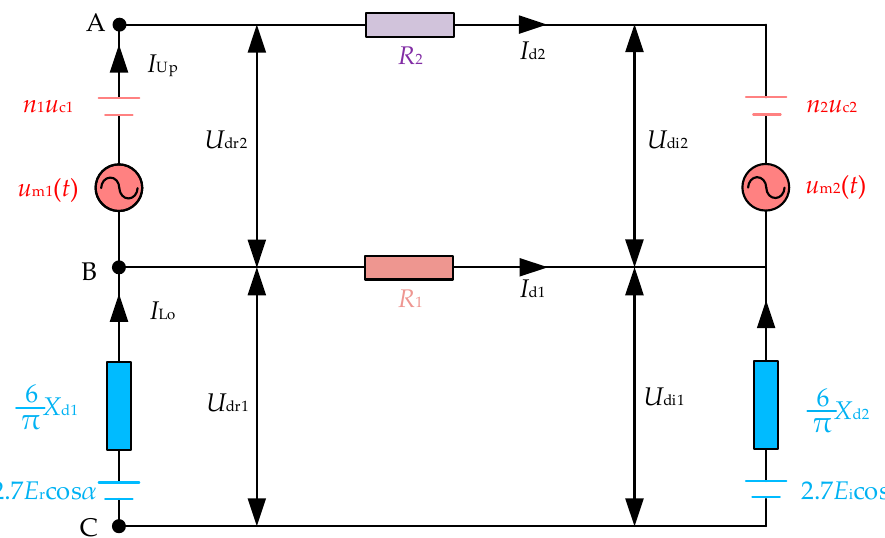
Figure 6. Equivalent circuit of simplified system.